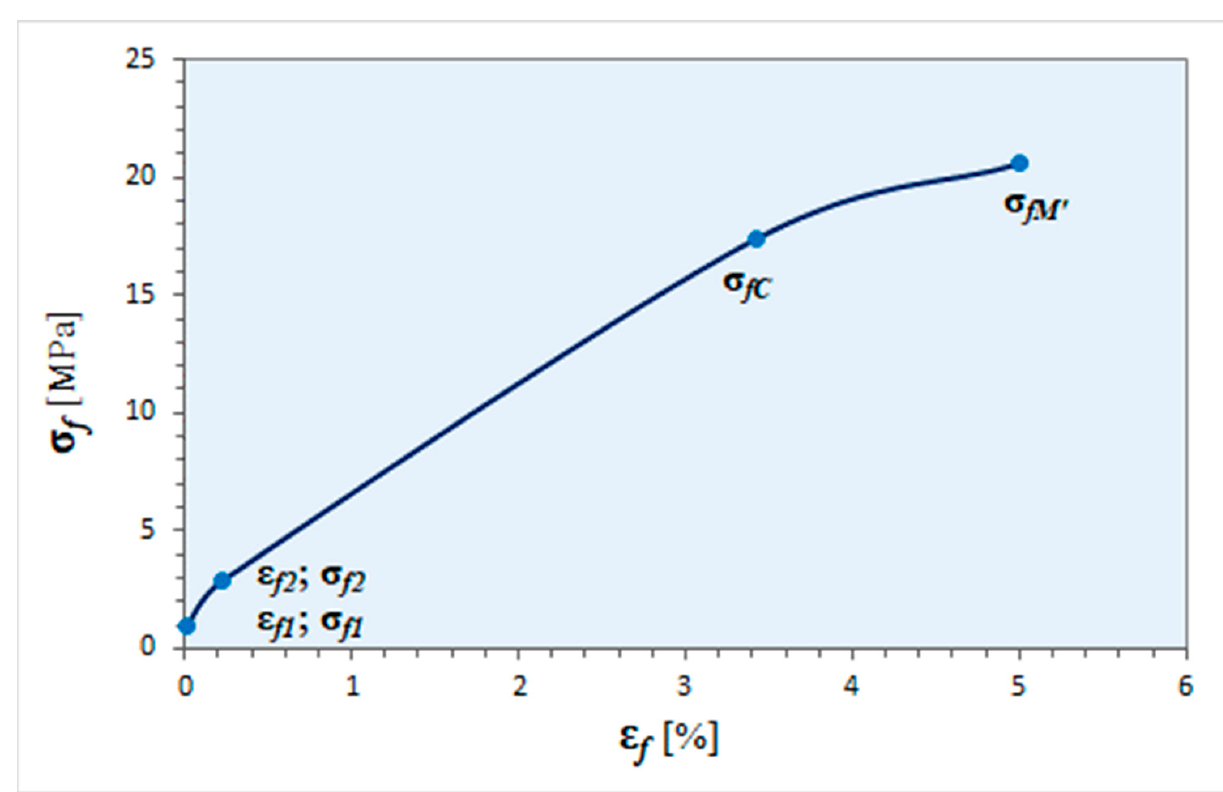
and Table 7—stress at the end of the test σ b’ determination.